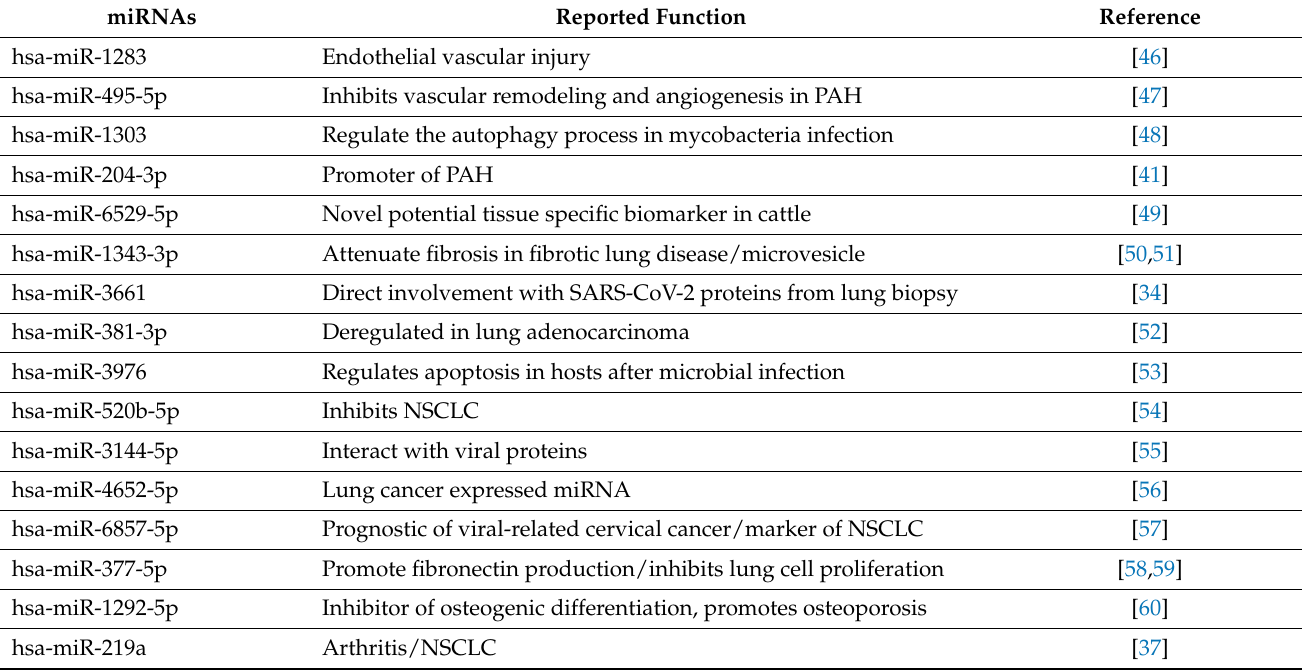
Table 1. Role of main miRNA candidates binding the leader sequence of SARS-CoV-2. miRNAs Reported